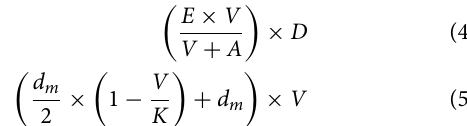
FIGURE 5 | The effects of seasonal variability on: (A) the mortality rate coefficient, and (B) the biting rate coefficient. These curves can be modeled as piecewise linear functions (Coffield et al., 2013). They can be produced using the Petri net submodel in Figure 6 . The time boundaries where the functions change their